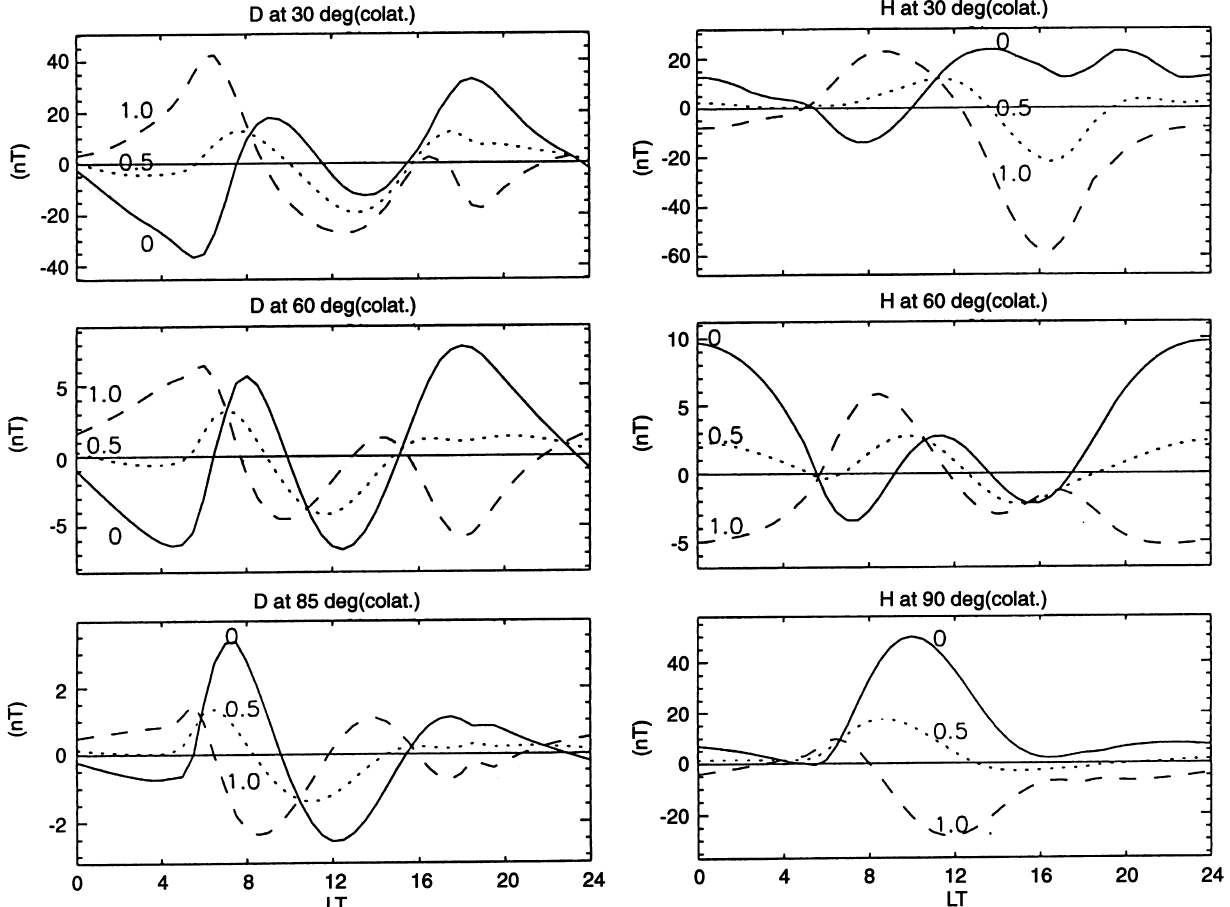
Fig. 7. Local time variations of D ( left panels ) and H ( right panels ) components of the magnetic fields at 60 (cid:176) , 30 (cid:176) latitudes and the equator calculated for the three models of source current composition. Labels as in